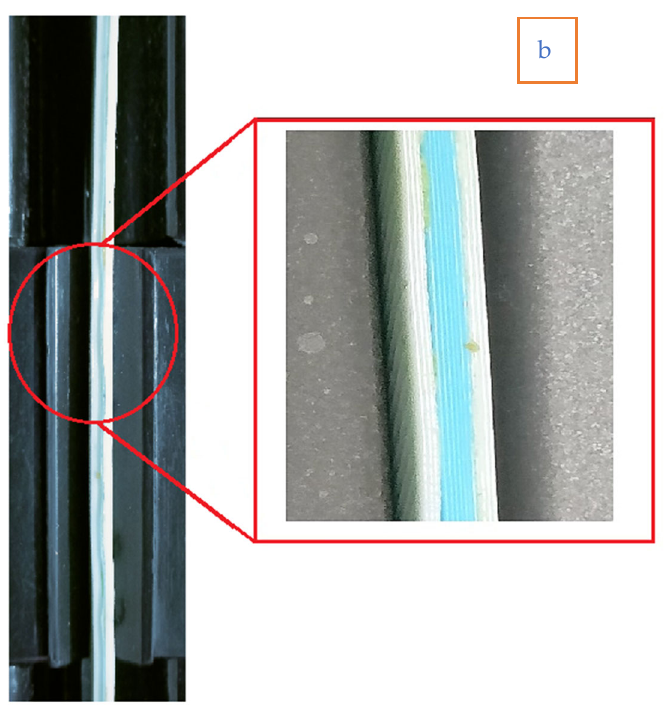
Figure 3. Flexural sample for ABS and TPU material ( a ) ATA and ( b ) TAT combination. Table 3. Design of experimentation for T/T1 ratio criteria. S.No.